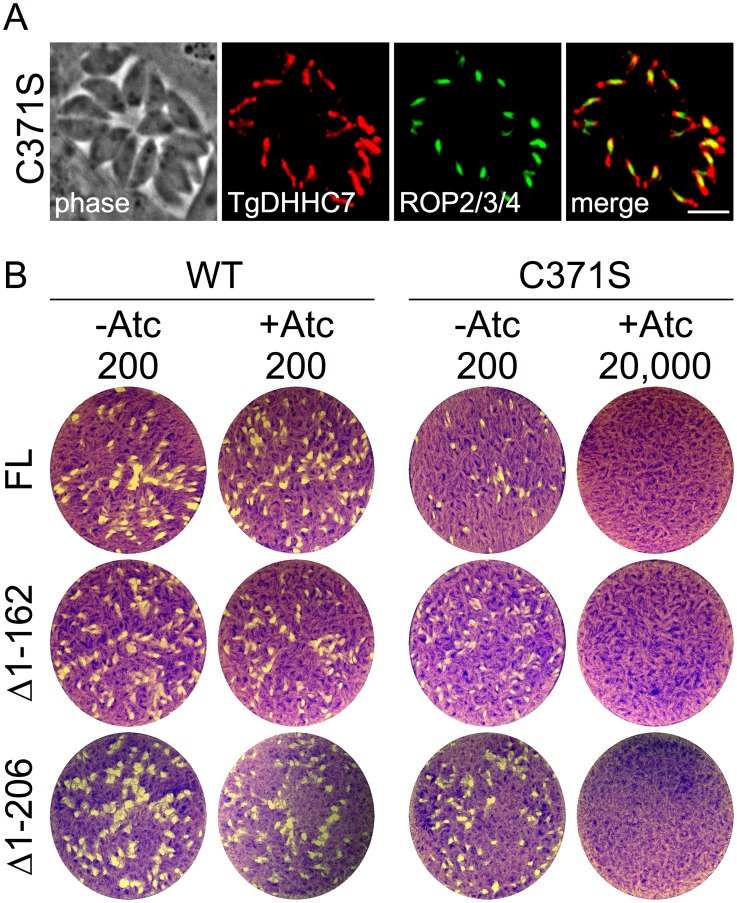
A key cysteine residue predicted to be required for TgDHHC7 catalytic activity is necessary for rhoptry function.(A) IFA showing localization of C371S mutant version of TgDHHC7. Targeting to the rhoptries is unaffected by the C371S mutation as assessed by co-localization with the rhoptry body protein ROP2/3/4. Red: anti-HA antibody detected by Alexa594-anti-rabbit IgG. Green: mouse anti-ROP2/3/4 antibody detected by Alexa488-anti-mouse. Scale bar = 5 µm. (B) Complementation of TgDHHC7cKO assessed by plaque assay. TgDHHC7FL-WT rescues the defect incurred by the knockdown of TgDHHC7 while TgDHHC7FL-C371S does not, failing to form plaques even with an infectious dose of 20,000 parasites per well. TgDHHC7 N-terminal truncations removing the first 162 or 206 residues also rescue the defect while C371S mutant versions of these truncation mutants do not.